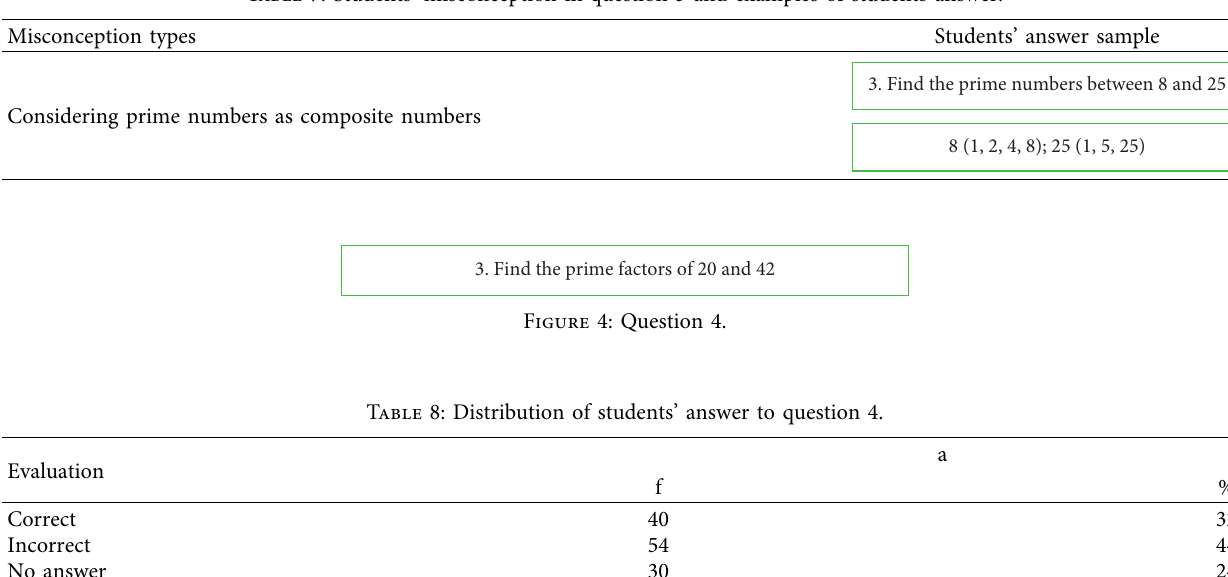
Table 7: Students’ misconception in question 3 and examples of students answer.